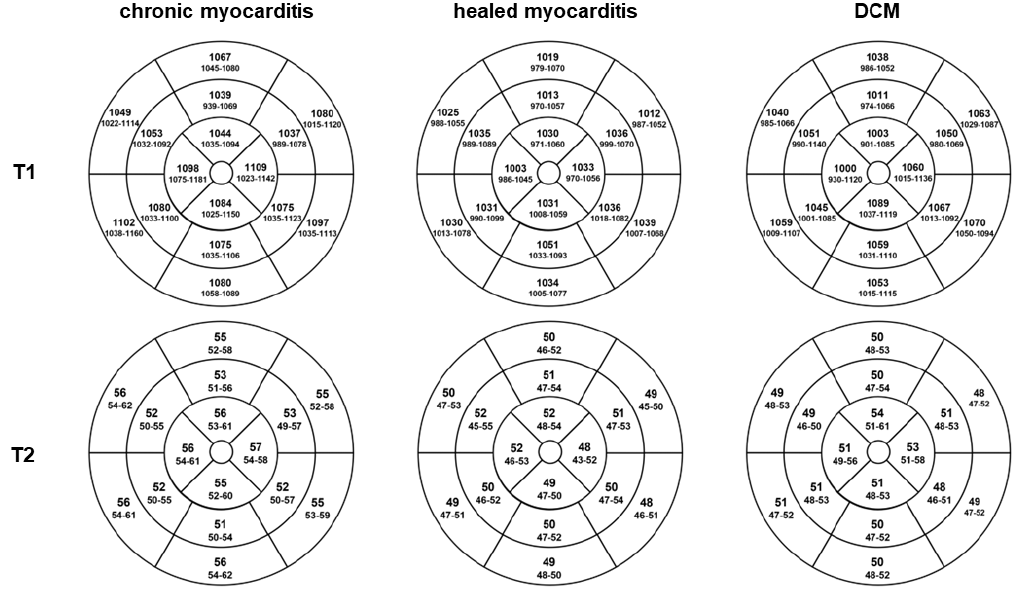
Figure 4. Mapping results. T1 and T2 relaxation times per AHA segment. Display of the median values (interquartile range) of T1 and T2 relaxation times in 16 segment models for chronic and healed myocarditis as well as DCM patients. Chronic myocarditis patients had higher T2 relaxation times with a median of 54 ms (IQR 52 – 57) than healed myocarditis with 50 ms (IQR 46 – 52) and DCM with 50 ms (IQR 49 – 52), respectively ( p < 0.0001). T1 values did not differ significantly.